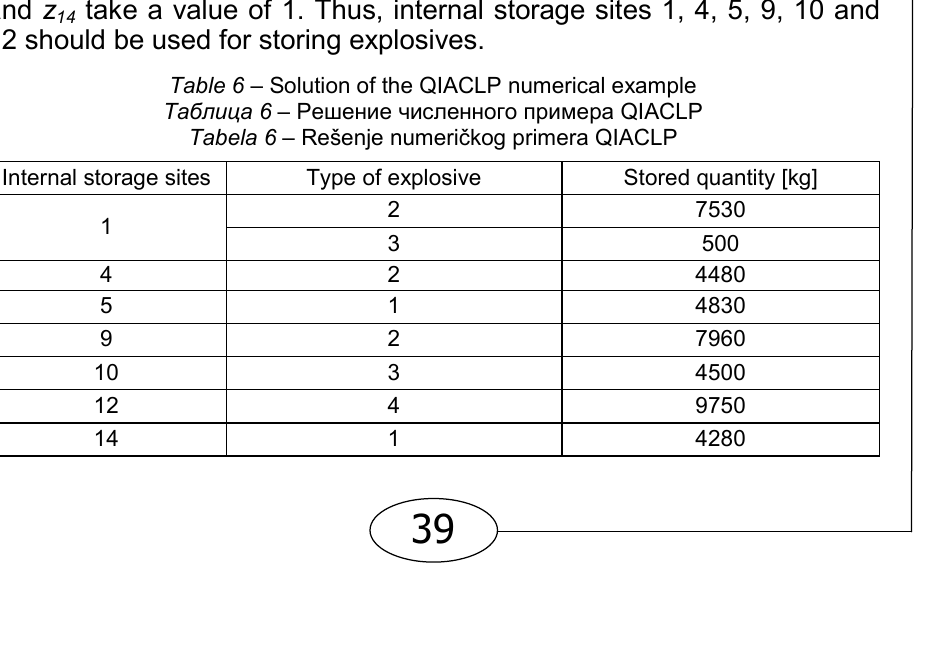
Figure 2 – Illustration of the QDACLP solution Рис . 2 – Иллюстрация решения QDACLP Slika 2 – Ilustracija rešenja QDACLP